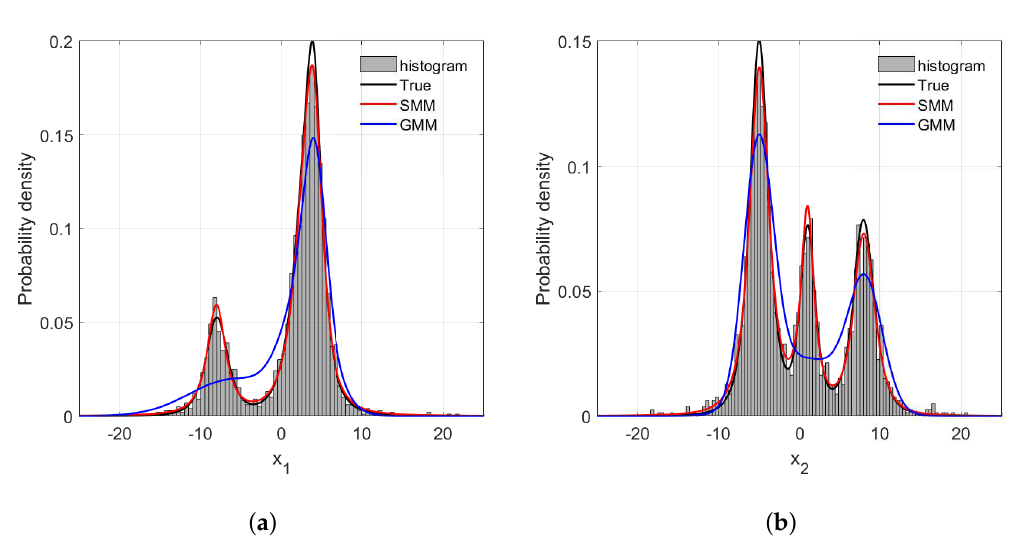
Figure 7. The frequency histogram and probability density curve with 5% rate outliers: ( a ) x 1 direction; ( b ) x 2